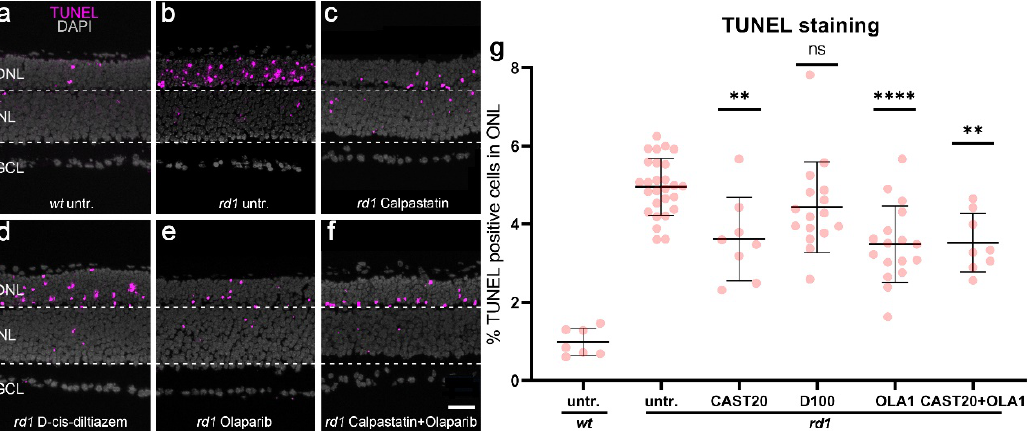
Figure 3. Effects of calpastatin, D-cis-diltiazem, Olaparib, and combination treatments on rd1 retinal cell viability. The TUNEL assay labeled dying cells (magenta) in wt and rd1 retinal explant cultures. DAPI (grey) was used as a nuclear counterstain. Untreated wt ( a ) and rd1 control retina (untr.; b ) were compared to retina treated with either 20-µM calpastatin (CAST20, c ), 100-µM D-cis-diltiazem (D100, d ), 1-µM Olaparib (OLA1, e ), or 20-µM calpastatin combined with 1-µM Olaparib (CAST20+OLA1, f ). Note the large numbers of dying cells in the rd1 outer nuclear layer (ONL). The scatter plot ( g ) shows the percentage of TUNEL-positive cells in the ONL. Statistical significance was assessed using one-way ANOVA and Tukey’s multiple comparison post hoc testing performed between the control ( rd1 untreated) and 20-µM calpastatin (CAST20), 100-µM D-cis-diltiazem (D100), 1-µM Olaparib (OLA1), and 20-µM calpastatin combined with 1-µM Olaparib (CAST20+OLA1). Except for D-cis-diltiazem, all treatments decreased rd1 retinal degeneration. The combination treatment CAST20+OLA1 did not improve the therapeutic effect seen with the respective single treatments. Untr. wt : 7 explants from 4 different mice; untr. rd1 : 27/27; CAST20 rd1 : 8/8; D100 rd1 : 16/16; OLA1 rd1 : 17/17; CAST20+OLA1 rd1 : 8/8; error bars represent SD; ns = p > 0.05, ** = p ≤ 0.01 , and **** = p ≤ 0.0001. ONL = outer nuclear layer, INL = inner nuclear layer, GCL = ganglion cell layer. Scale bar = 50 µm.